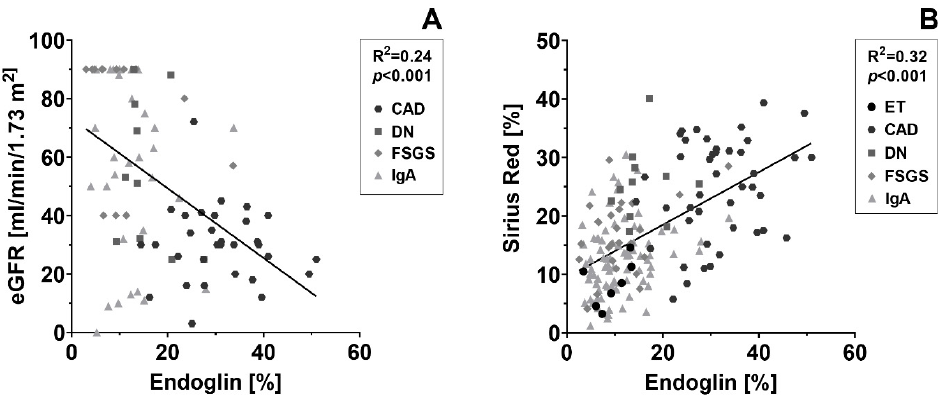
Figure 2. Endoglin expression correlates with kidney function and interstitial collagen deposi- tion. ( A ) The interstitial area positive for endoglin is plotted against the estimated glomerular filtration rate (eGFR) per patient. The regression line is based on the pooled measurement of CAD, DN, FSGS and IgA nephropathy, which was considered justified after performing interaction analysis. R 2 of the regression is 0.24, p < 0.001. ( B ) The interstitial area positive for endoglin is plotted against the Sirius Red-positive interstitial area, which is a measure for interstitial fibrosis. The regression line is based on the pooled measurement of ET, CAD, DN, FSGS and IgA nephropathy, which was considered justified after performing interaction analysis. Data were corrected for eGFR, R 2 of the regression is 0.32, p < 0.001.